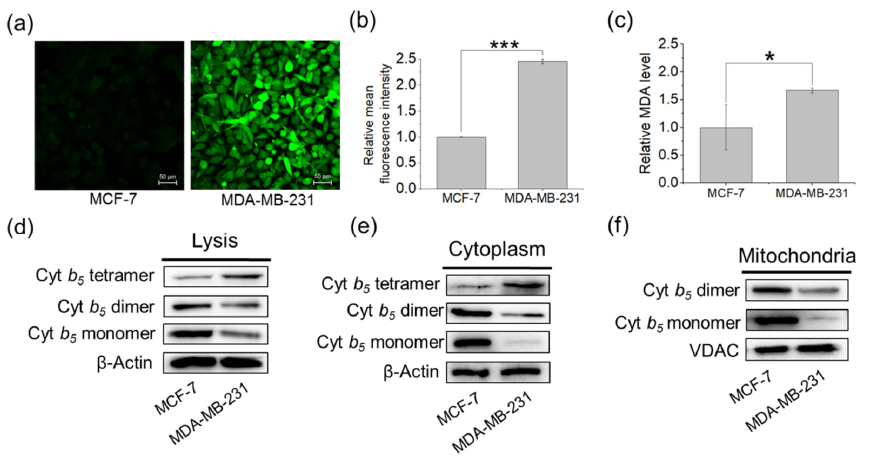
Figure 1. Analysis of oxidative stress and Cyt b 5 content in MDA-MB-231 and MCF-7 cells. ( a ) Analysis of ROS levels in MDA-MB-231 and MCF-7 cells by treating with DCFH-DA reagent. ( b ) ROS detection was quantified by using ImageJ software and the optical densitometry was reported. (*) P < 0.05; (**) P < 0.01; (**) P < 0.001. ( c ) Analysis of MDA levels in MDA-MB-231 and